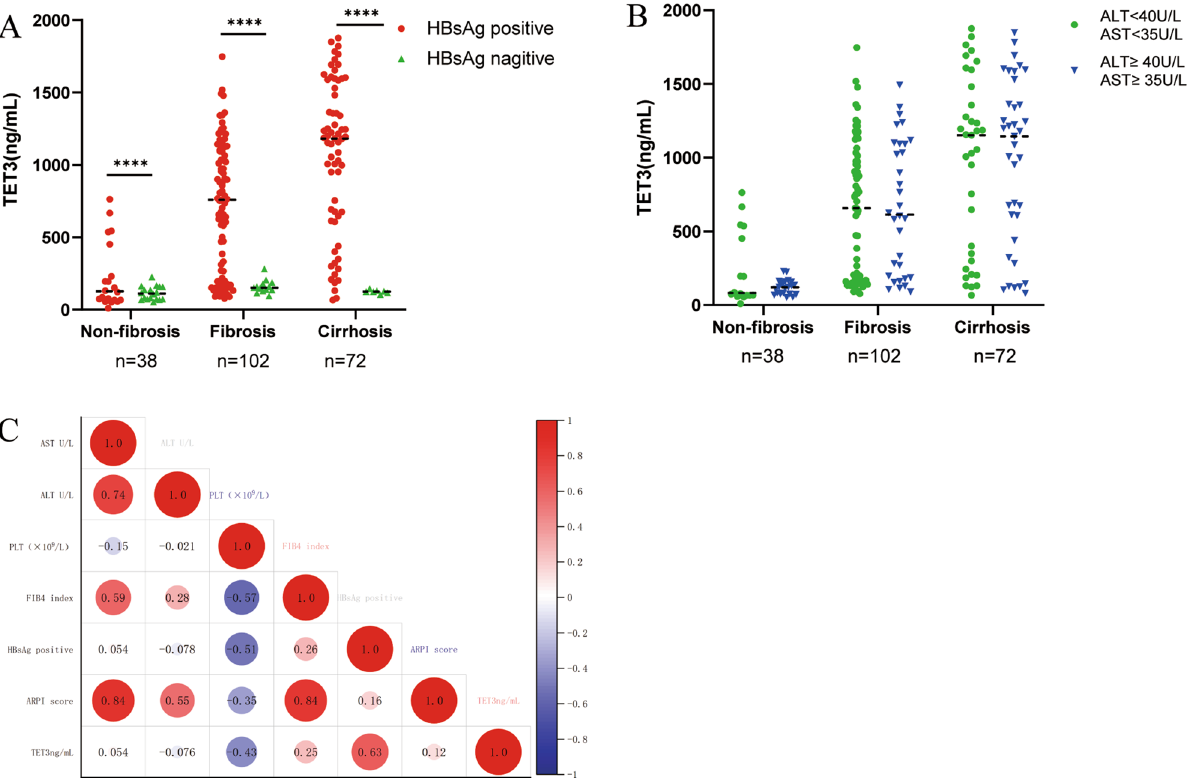
Figure 2. Serum levels of TET3 and Clinical indicators. ( A ) When HbsAg were more than or less than 0.4 IU/ mL, TET3 levels were observed between non-fibrosis, fibrosis and cirrhosis groups; ( B ) When AST and ALT were more than or less than 35 U/L or 40U/L, TET3 levels were observed between non-fibrosis, fibrosis and cirrhosis groups; ( C ) Correlation of TET3 level and clinical indicators in all patients.